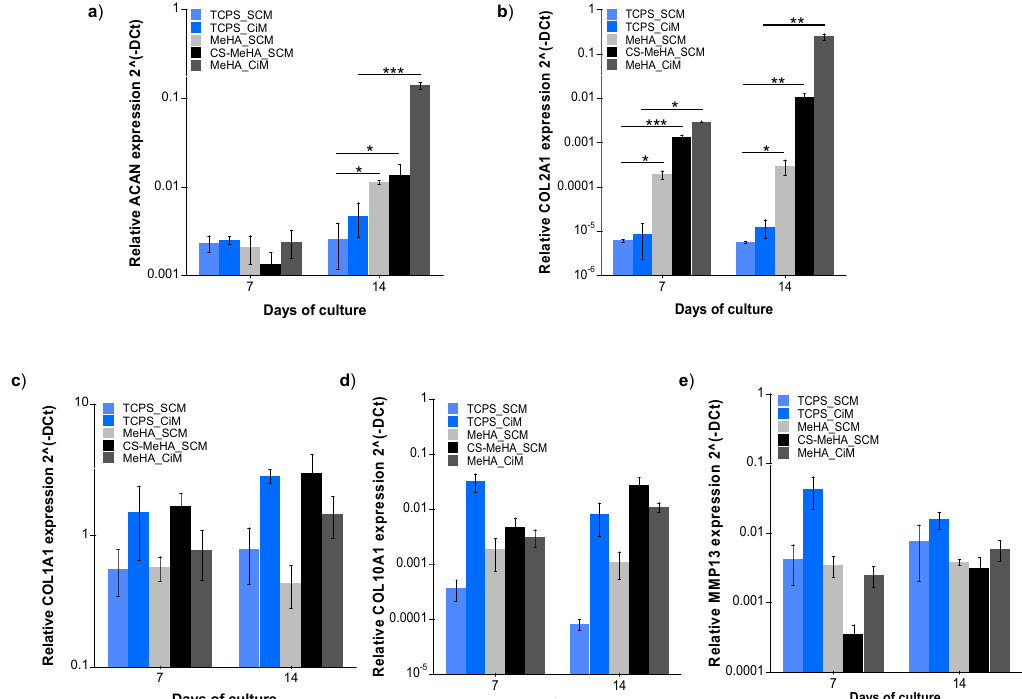
Figure 7. Gene expression analysis of ( a ) ACAN, ( b ) Col2A1, ( c ) Col1A1, ( d ) Col10A1, and ( e ) MMP13 for hMSCs encapsulated in MeHA or CS-MeHA hydrogels, and for hMSCs cultured on tissue culture polystyrene (TCPS) (control) following 7 and 14 days of in vitro culture in SCM or CiM. The data were analyzed with one-way ANOVA and are presented as mean values ± standard error of the mean, * p < 0.05, ** p < 0.01, *** p < 0.001 ( n = 3 for each donor, hMSCs derived from three different donors).